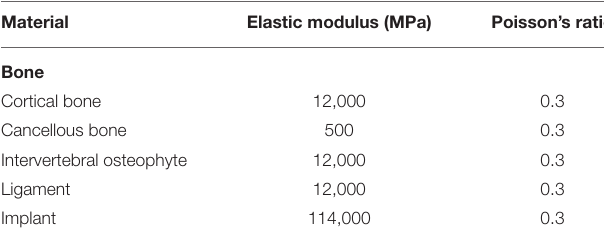
TABLE 1 | Material properties of finite element